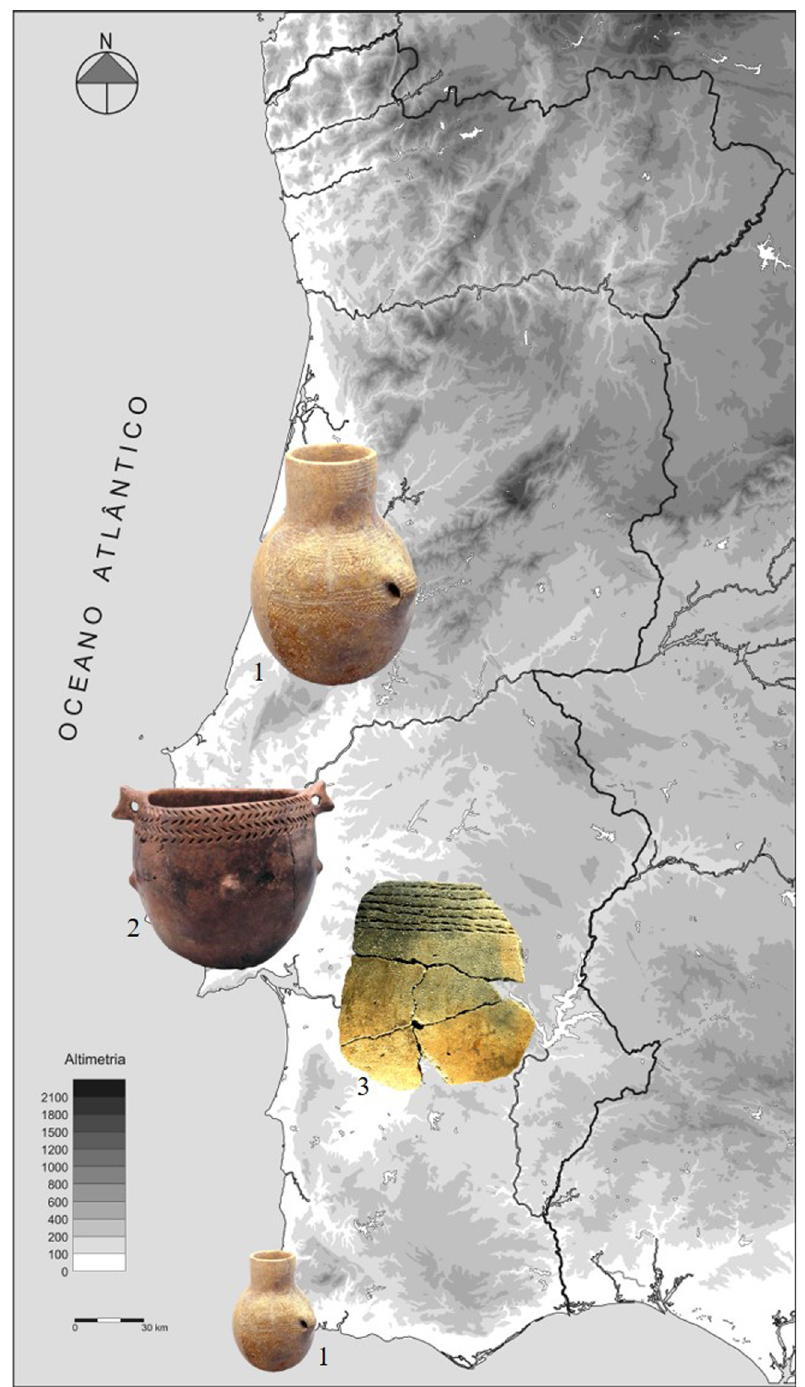
Figure 3: Southern Portugal Early Neolithic pottery traditions. ( 1 ) Upper Estremadura illustrated after Santarém cardial vessel ( Matriznet.dgpct.pt ) , ( 2 ) lower Estremadura after Nossa Senhora da Luz – false acacia leaf vessel ( Matriznet.dgpct.pt ) , and ( 3 ) interior/Southern Portugal after Valada do Mato impressed stripes vessel ( Diniz, 2007 ) . Cartography after Boaventura ( 2009 )